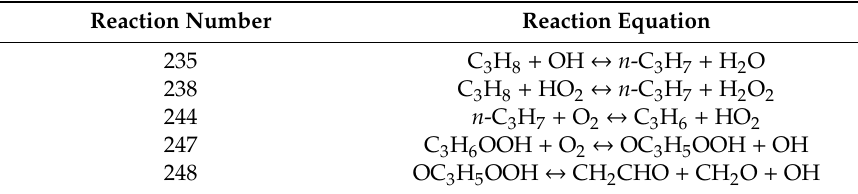
Table 3. Overview of the reactions used to adjust the calculation of the propane influence on the IDT.